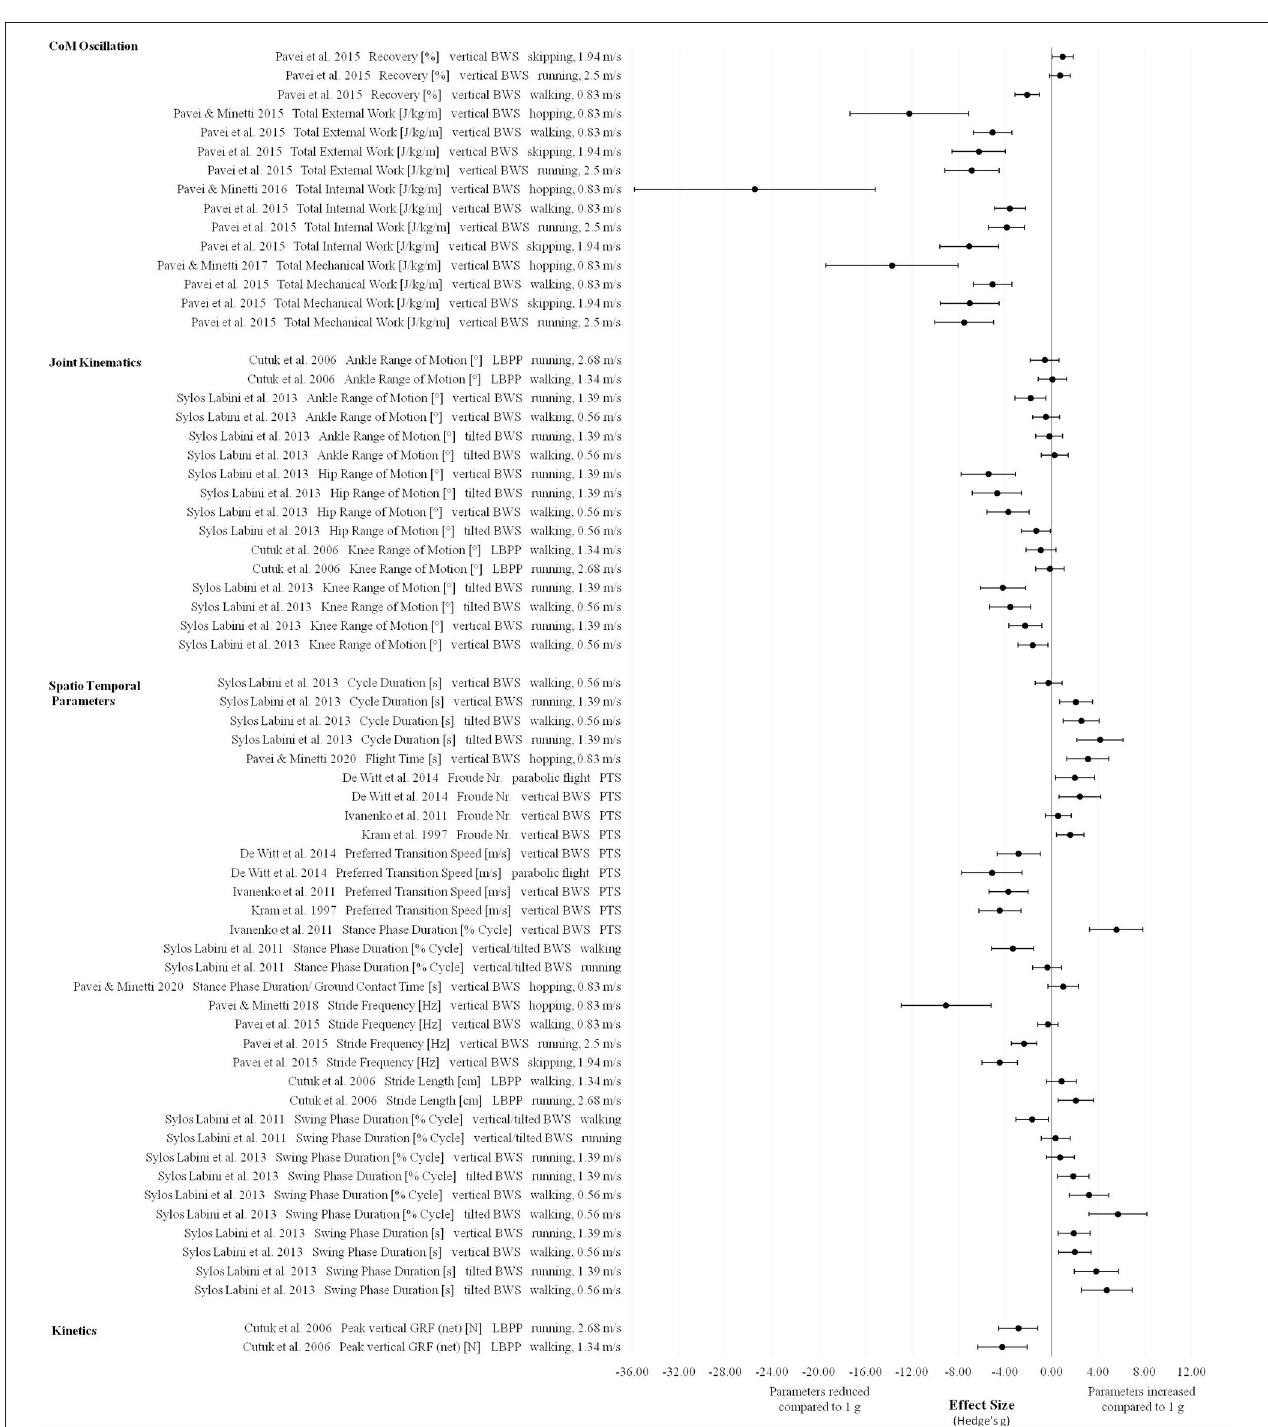
FIGURE 7 | Effect sizes (Hedge’s g) and confidence intervals for biomechanical parameters in Lunar gravity compared to 1g.